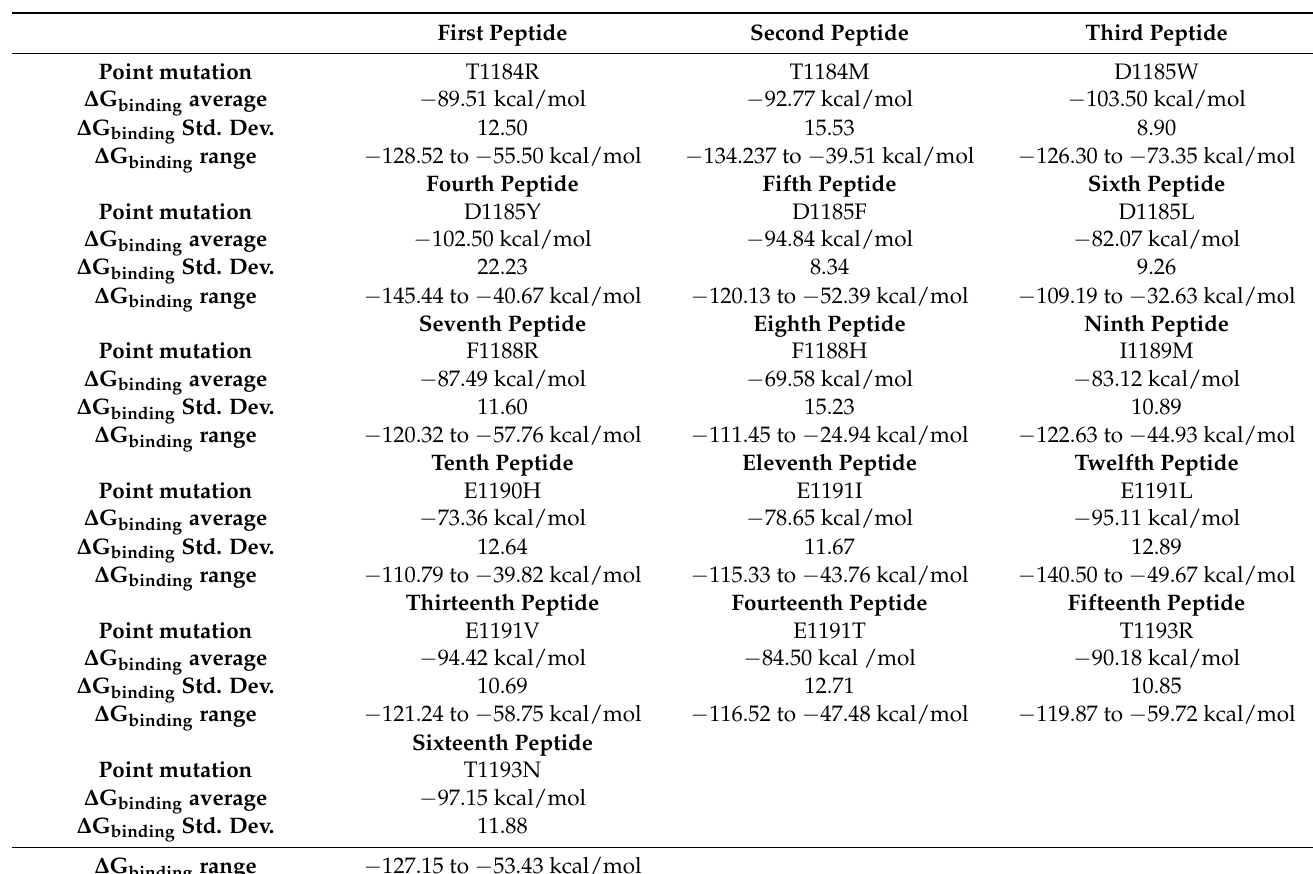
Table 6. MM-GBSA calculation results based on MD simulations of the 16 point-mutated 3 10 -HBS RB3 peptides in complex with the Ras